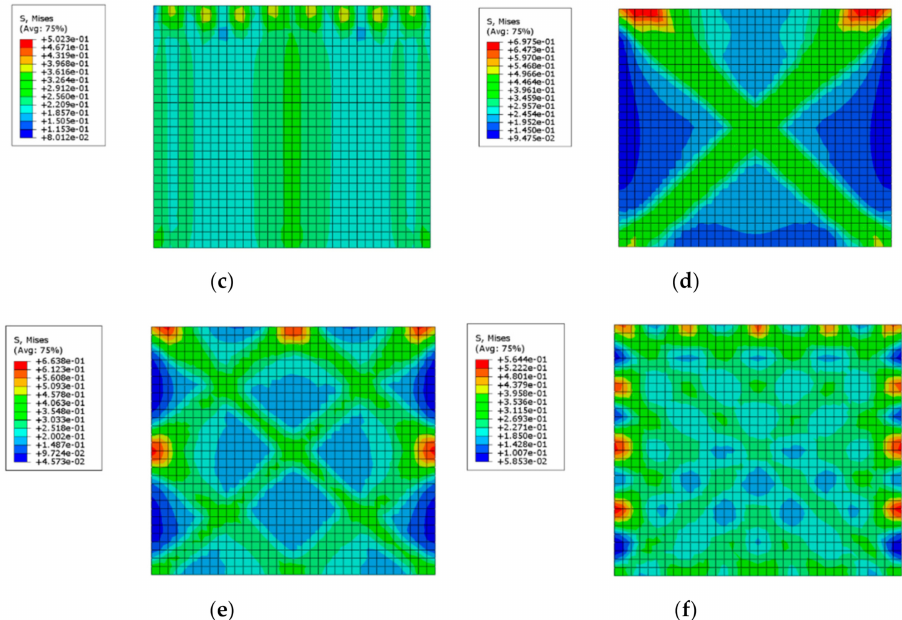
Figure 13. Stress distribution in numerically studied models, ( a ) UMW2, ( b ) UMW3, ( c ) UMW4,